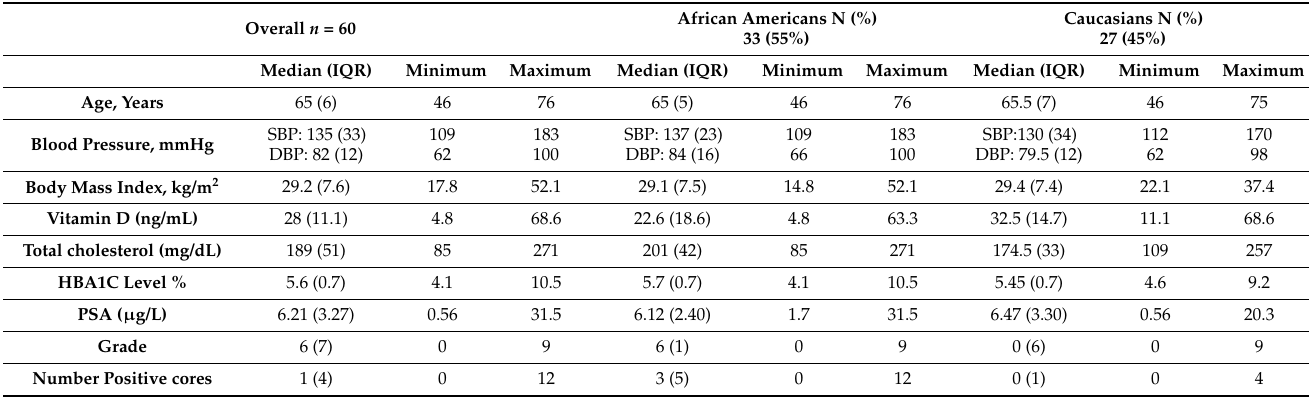
Table 1. Patient demographics and measured clinical